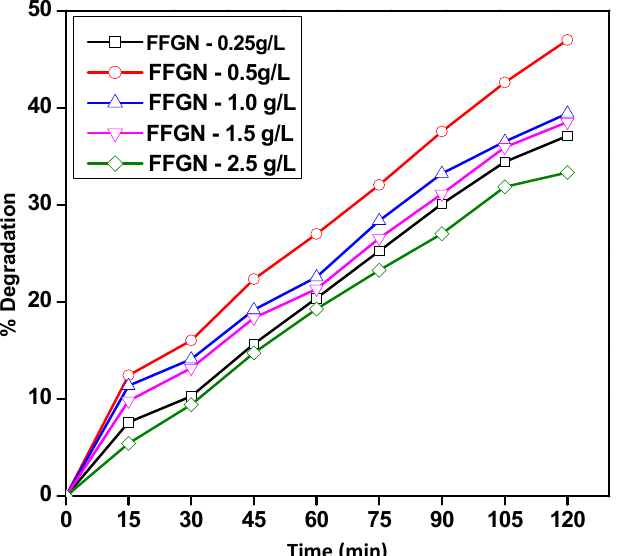
Figure 3. Degradation of ANB at different FFGN concentrations (pH = 3.0 ± 0.2, ANB = 50 ppm, Amplitude = 40%, Probe = 25 mm, T = 25 ± 1 °C) .